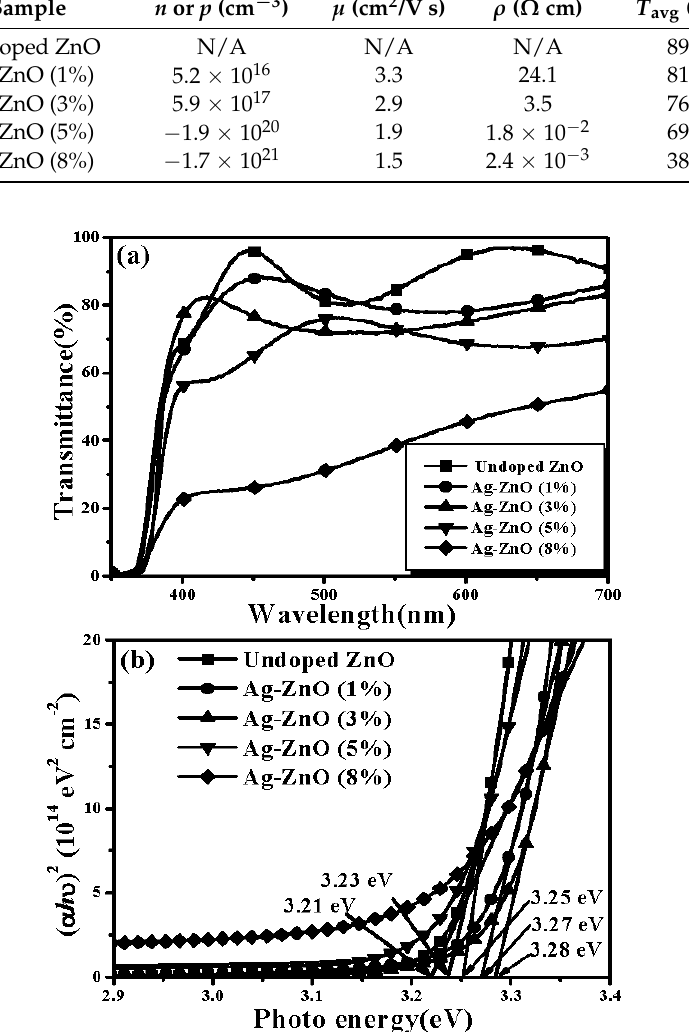
Figure 2. ( a ) Optical transmittance spectra and ( b ) the plot of ( α h ν ) 2 versus the photon energy of the undoped ZnO and Ag-ZnO co-sputtered films annealed at 350 °C for 1 h under ambient air.